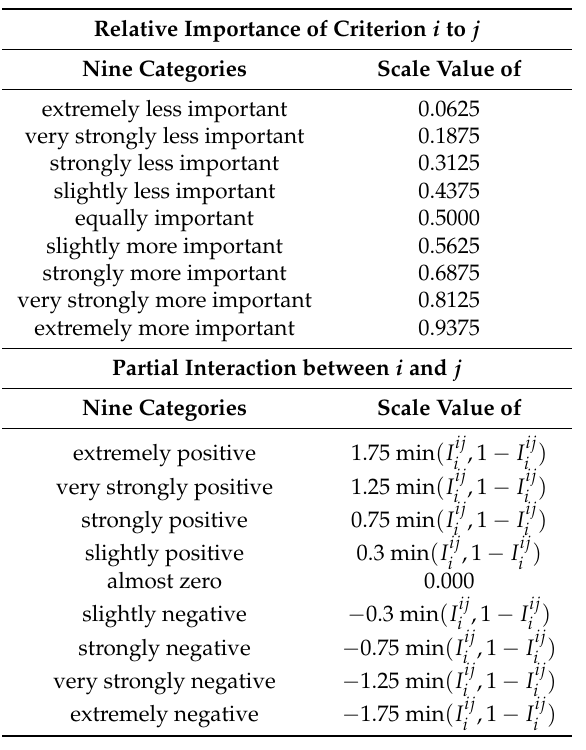
Table 1. The scale of 2-dimensional multicriteria correlation preference information